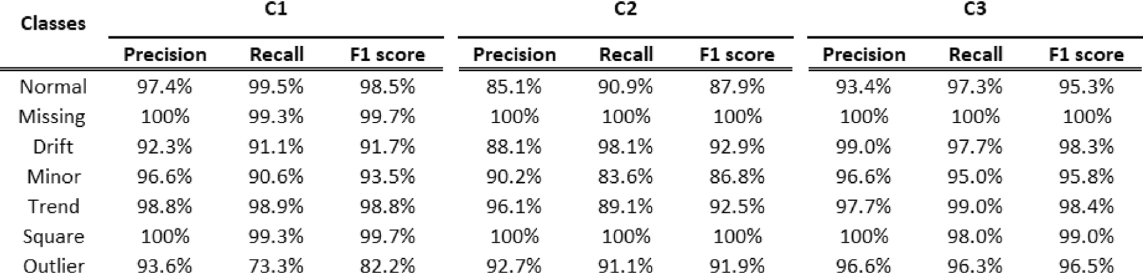
Table 9 Precision, Recall and F1 score for each